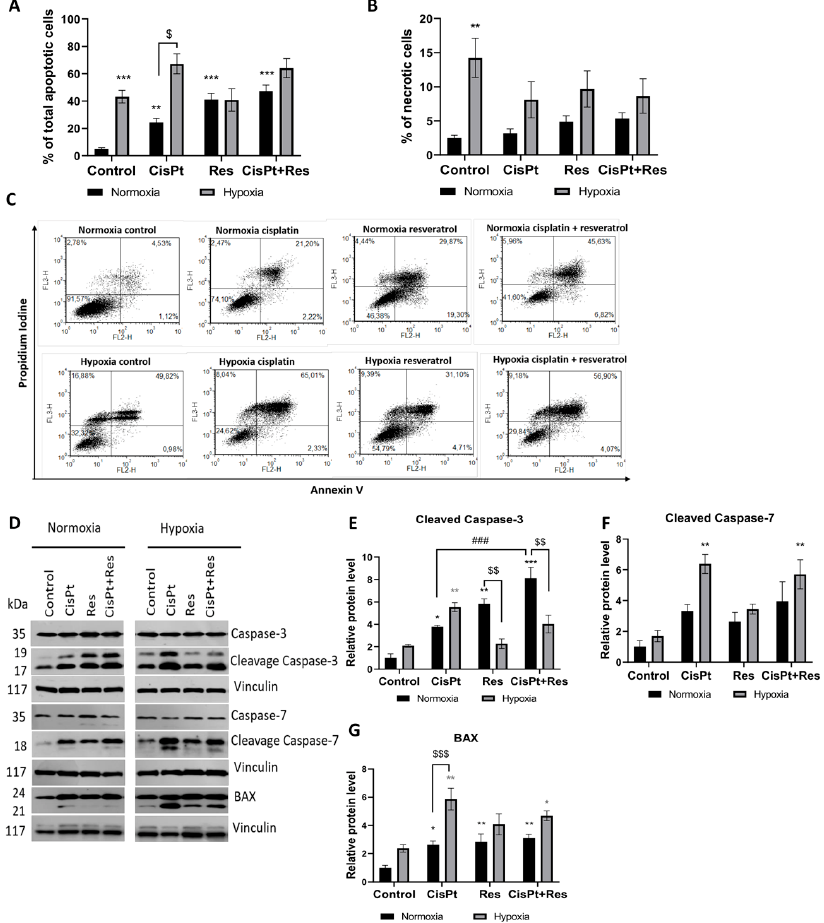
Figure 3. Analysis of cisplatin, resveratrol, and in combination to induce apoptosis in OC cells under normoxic and hypoxic conditions by flow cytometry and Western blot. A2780 cells were treated with cisplatin (CisPt) (5.9 µ M), resveratrol (Res) (63 µ M), and in the combination CisPt+Res (at the same concentrations) according to Section 4.4: Establishment of Hypoxic Culture Condi- tions and Experimental Outline. ( A ) Percentage of apoptotic cells; ( B ) percentage of necrotic cells; ( C ) representative histograms from apoptosis analysis in A2780 cells; ( D – G ) Western blot analysis of cleaved caspase-3, cleaved caspase-7, and BAX protein expression. The graphs represent the densitometric analysis of the immunoblots. Vinculin was used as a loading control and normalized to the normoxia control as 1. The results shown are the mean ± SEM of three independent experiments, with *** p < 0.001, ** p < 0.01, * p < 0.05, vs. normoxia control (black asterisk) and vs. hypoxia control (grey asterisk); $$$ p < 0.001, $$ p < 0.01, $ p < 0.05 comparing the normoxia group with the hypoxia group; and ### p < 0.001, CisPt alone vs.